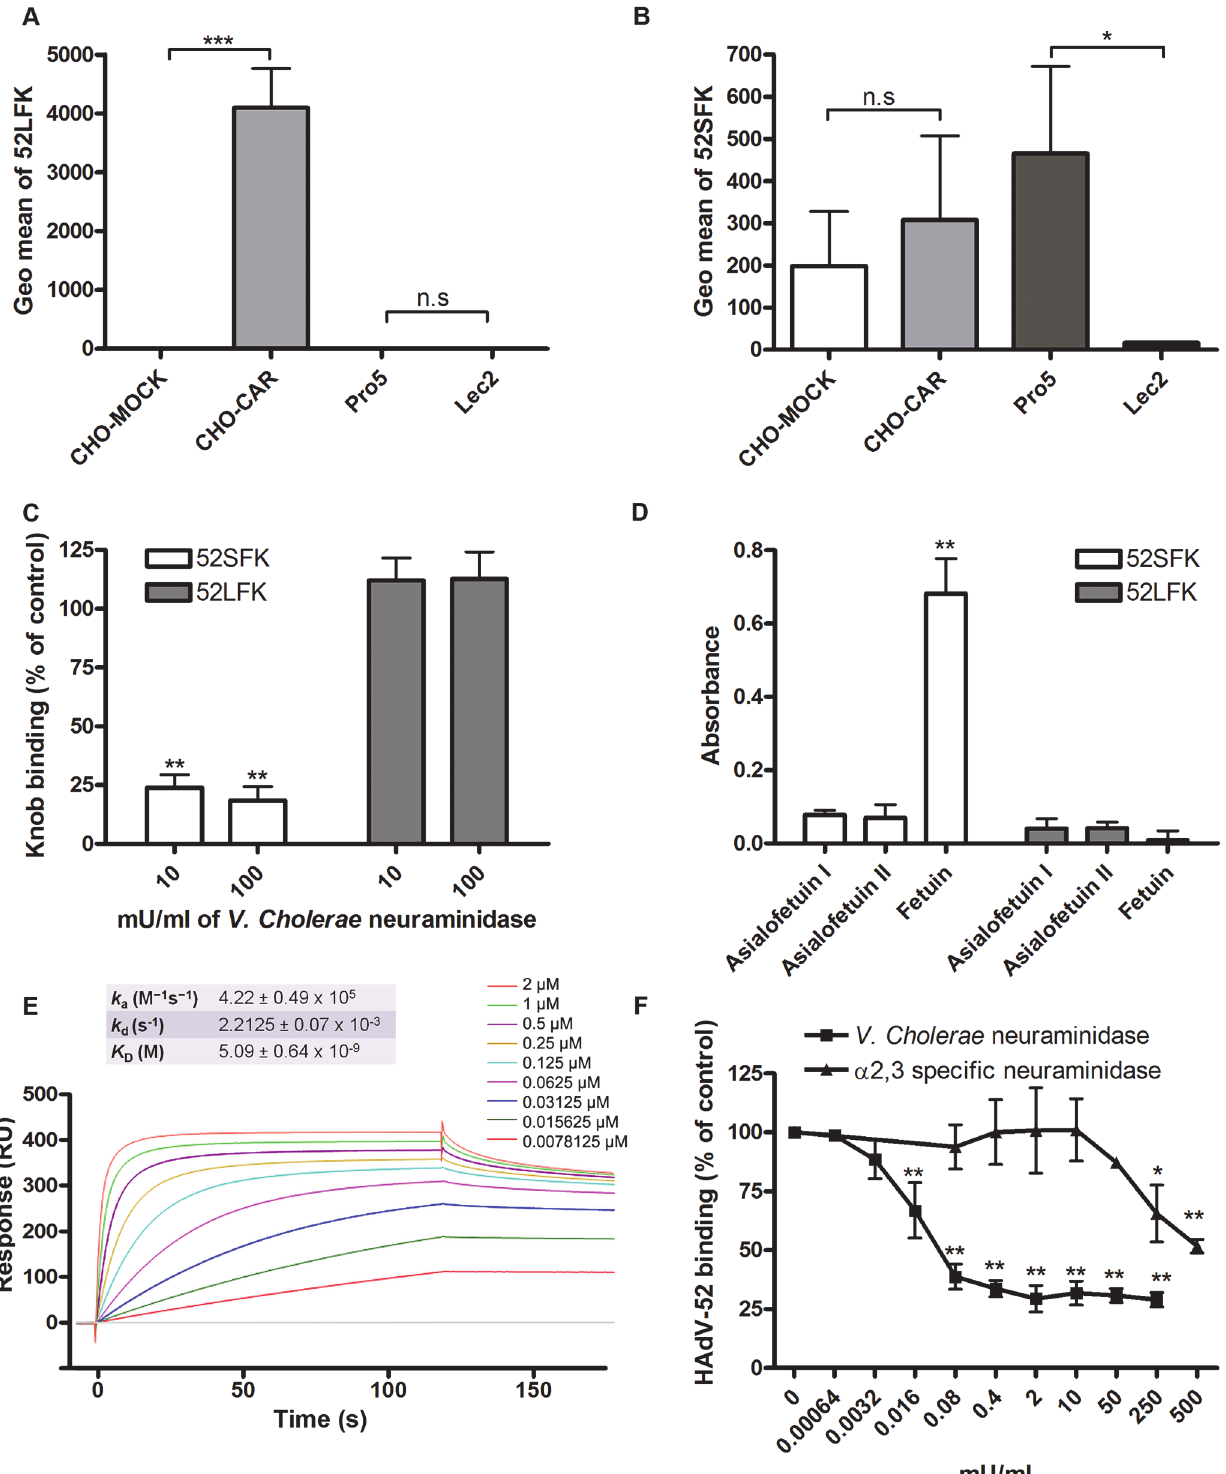
Fig 5. HAdV-52 short fiber knob binds to sialic acid and long fiber knob binds to CAR. (A) HAdV-52 long fiber knob (52LFK) and (B) HAdV-52 short fiber knob (52SFK) binding to CHO-cells lacking human CAR (all cells except CHO-CAR), lacking sialic acid (only Lec2) and expressing human CAR (CHO- CAR). (C) 52SFK and 52LFK binding to A549 cells pretreated with V . cholerae neuraminidase. (D) ELISA analysis of 52SFK and 52LFK (in solution) binding to immobilized, sialylated fetuin and asialofetuin type I (chemically prepared) and II (enzymatically prepared). Relative absorbance is shown. (E) Surface